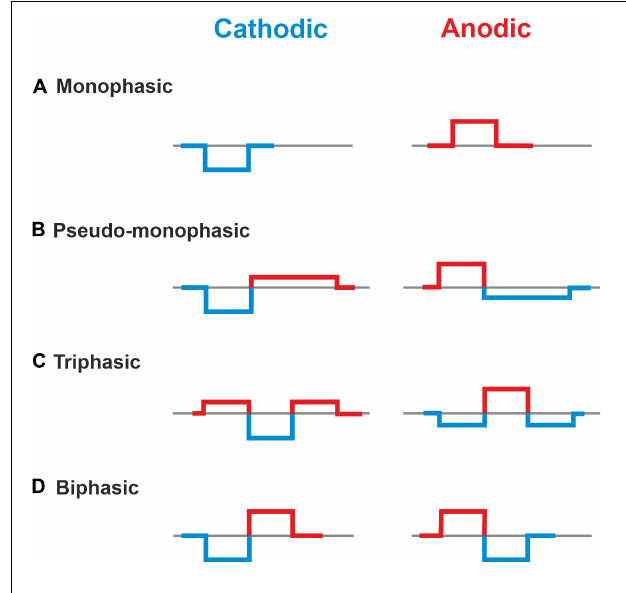
All multicompartment model evaluations were performed in MATLAB (version R2020a 2 ).